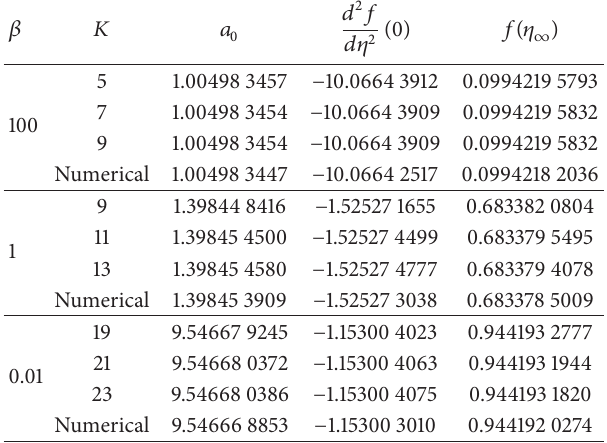
Table 1: Dependence of 𝐾 on 𝛽 [ 𝜆 = 1.5 ( 𝛼 = 3 ), 𝛾 = 0